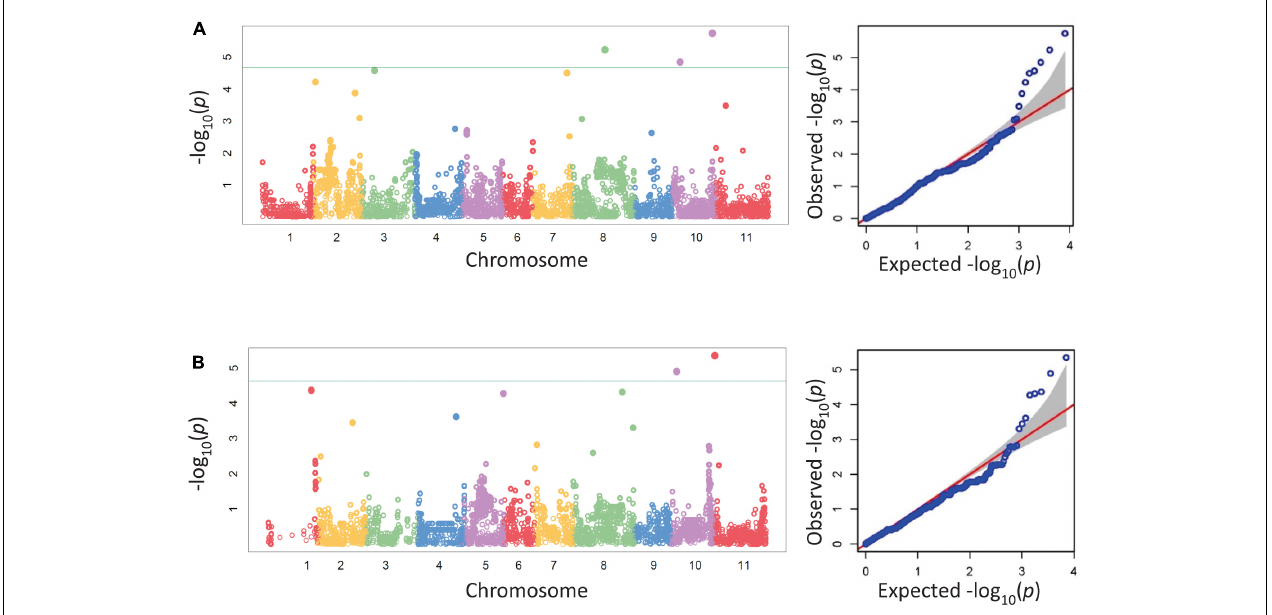
FIGURE 1 | Manhattan and corresponding Q-Q plots from a GWAS analysis of disease severity (A) and biomass (B) in the BeanCAP Snap Bean Diversity Panel evaluated in 2 years for Fusarium solani reaction at the Oregon State University Vegetable Research Farm. The Bonferroni cutoff based on effective marker number (-log 10 4.68, α = 0.05) is shown as a solid line. For the Q-Q plots, the null distribution is shown as a red line.